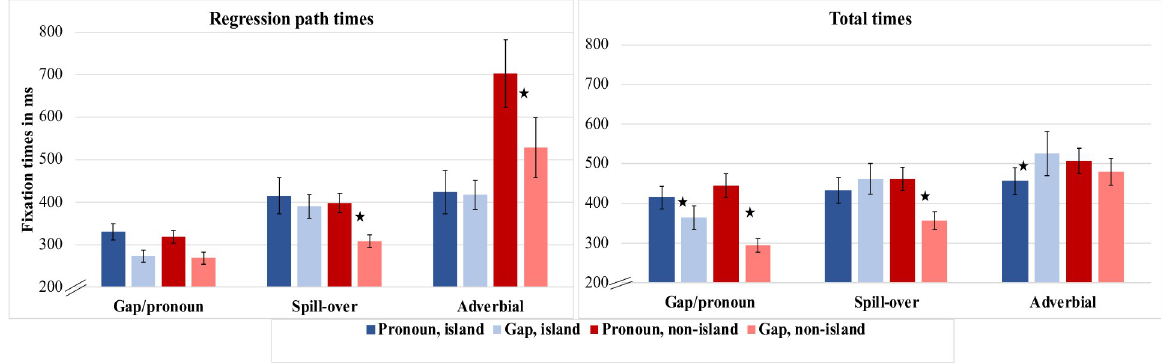
Fig 1. Regression path time and total time (ms) across regions, for Experiment 1.